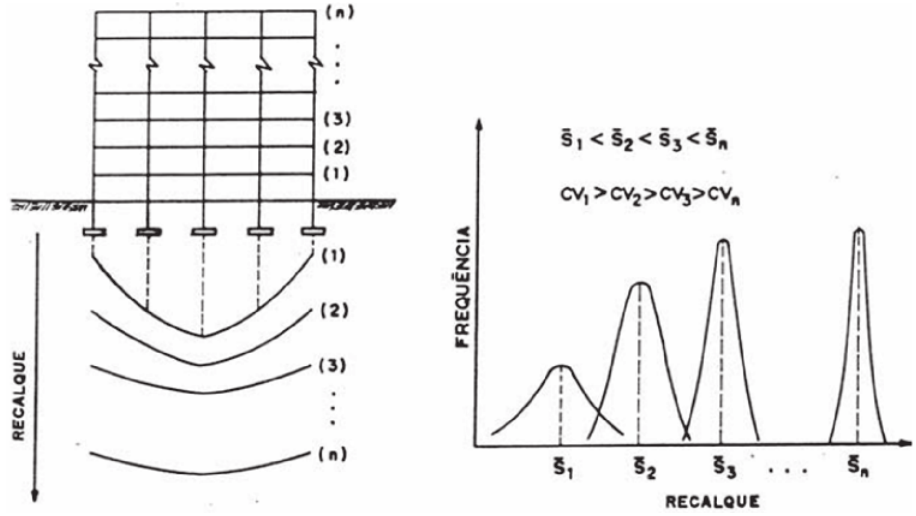
Efeito da sequência executiva, Gusmão Filho